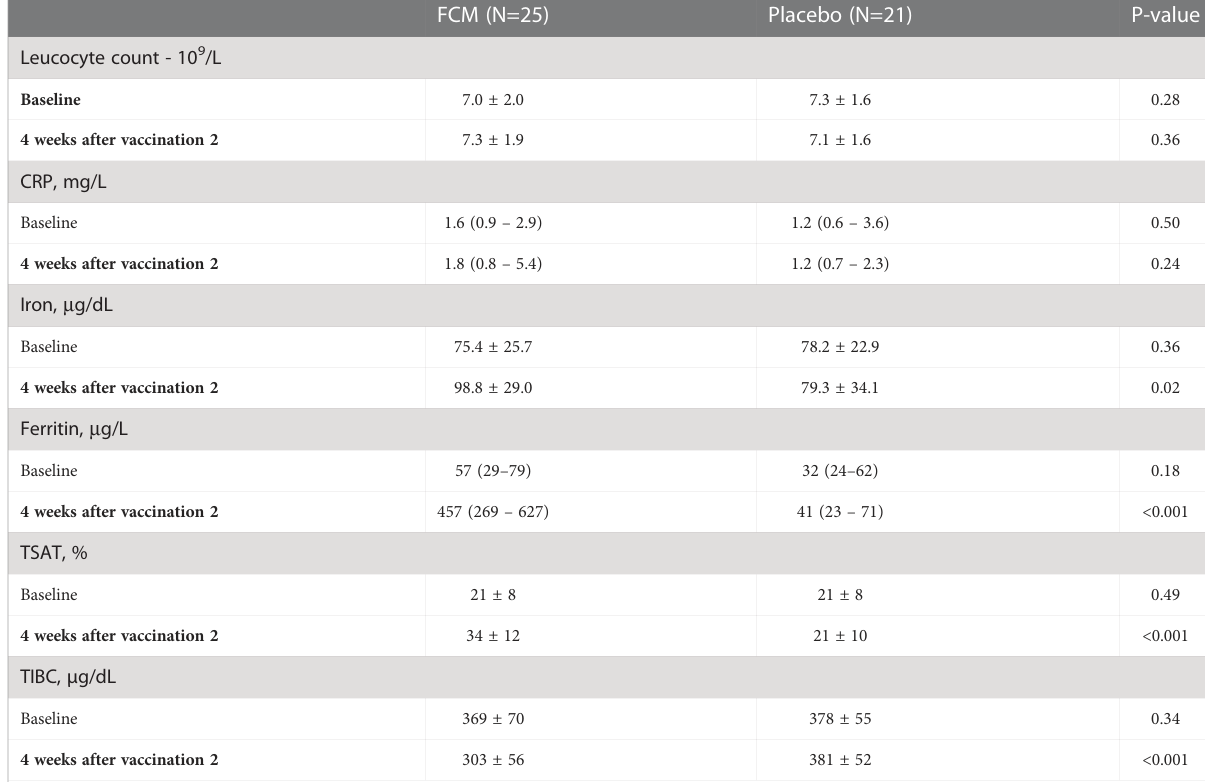
TABLE 2 In fl ammation and iron status parameters at baseline and four weeks after the second